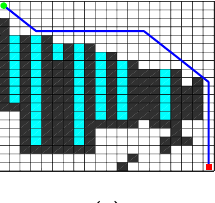
Figure 14. Death Strategy Optimisation Path Diagram; ( a ) Optimal path diagram; ( b ) All ants’ paths diagram; ( c ) Iterative diagram of the optimal path; and ( d ) Iterative diagram of ants’ paths.